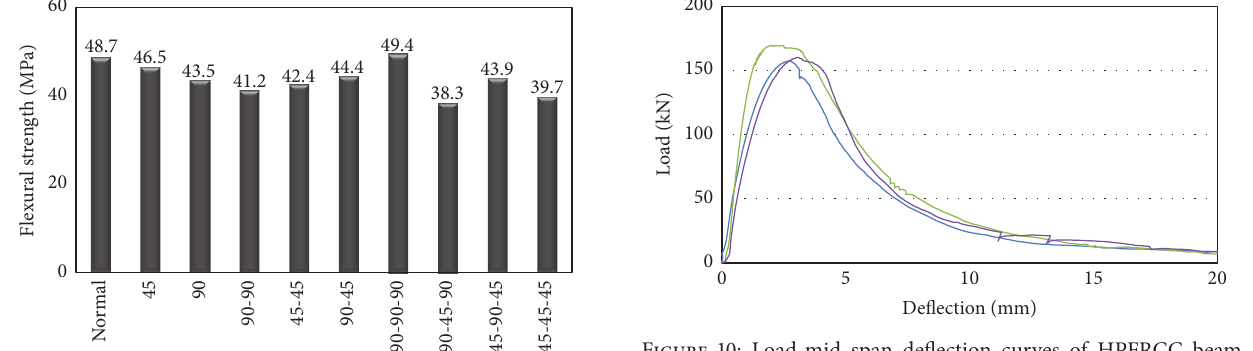
Figure 10: Load-mid span deflection curves of HPFRCC beam without BFRP.